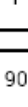
Figure 1. 90 % of content is made by 1 % of active users